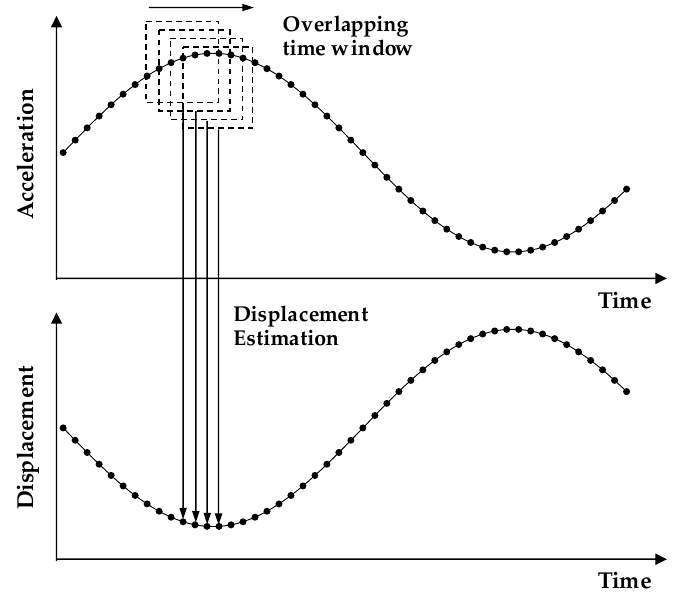
Figure 1. Displacement estimation scheme using overlapping time window .